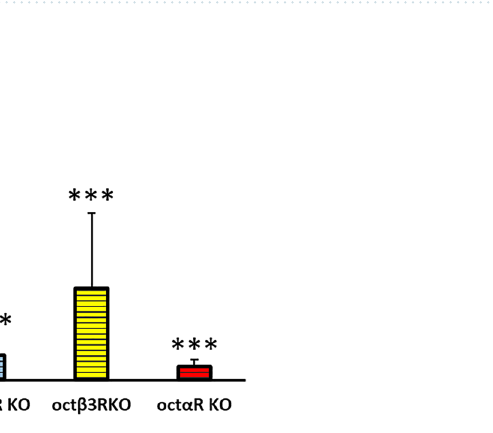
Figure 2. Climbing speed of adult Drosophila males that lost the expression of four different receptors receptive for octopamine using ubiquitous driver line tubP- GAL4 as compared to controls. The experiment was performed in triplicate. Mean ± SD; N = 10; * P ˂ 0.05, ** P ˂ 0.01, *** P ˂ 0.001.